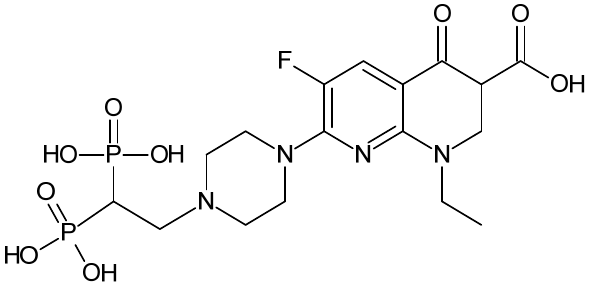
Figure 7. Structure of bis ‐ enoxacin.